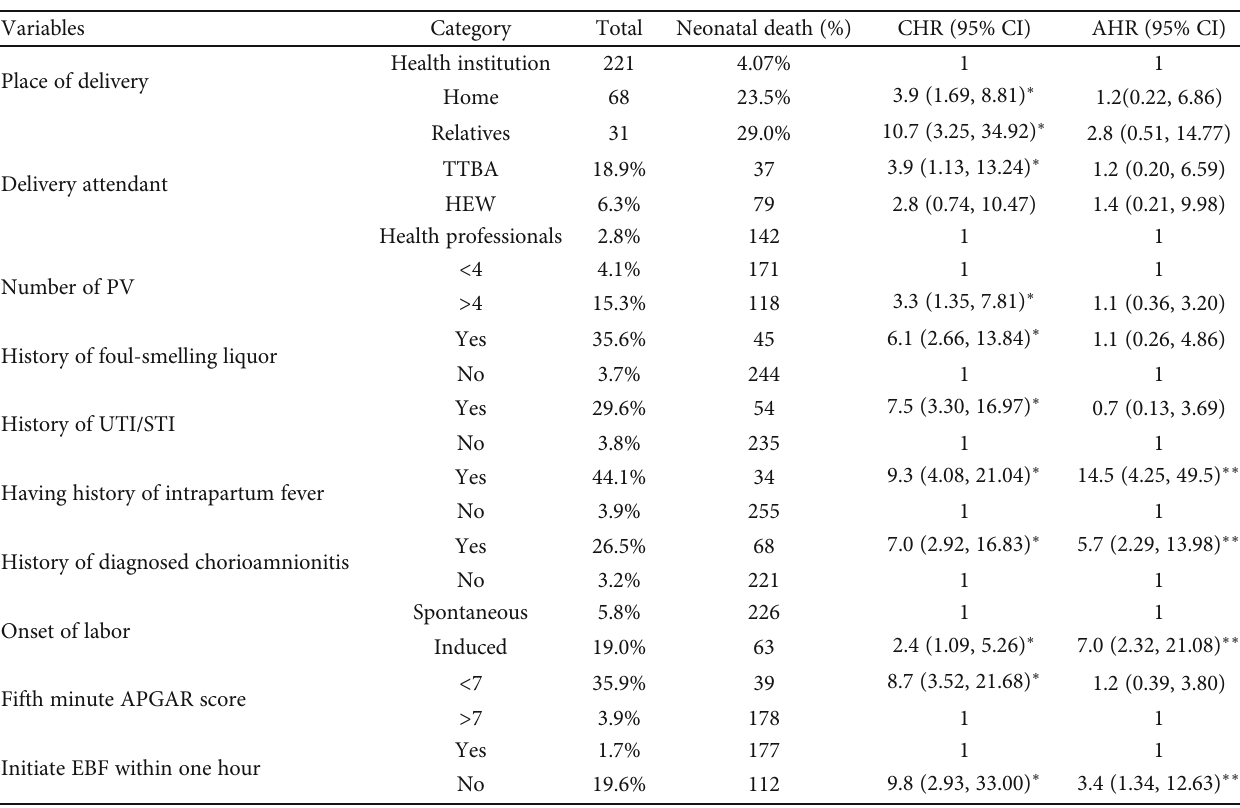
Table 6: Predictors of mortality among neonates with neonatal sepsis at public hospitals in